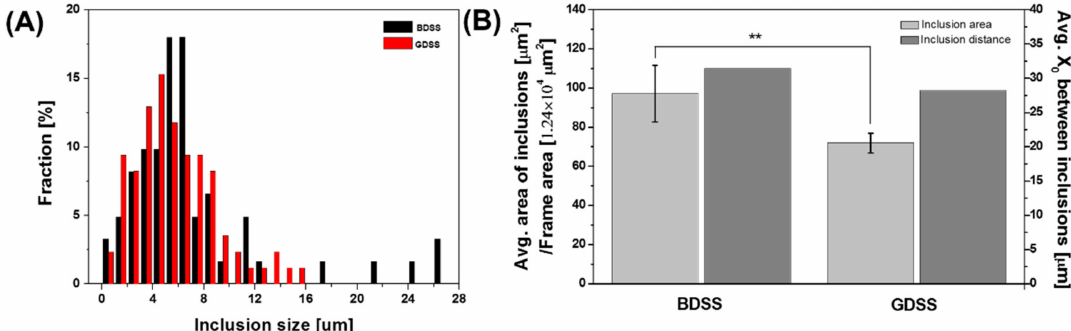
Figure 5. ( A ) Inclusion size distributions of as-cast SDSSs. ( B ) the average area of inclusions and the average distance between inclusions in BDSS and GDSS (** p <